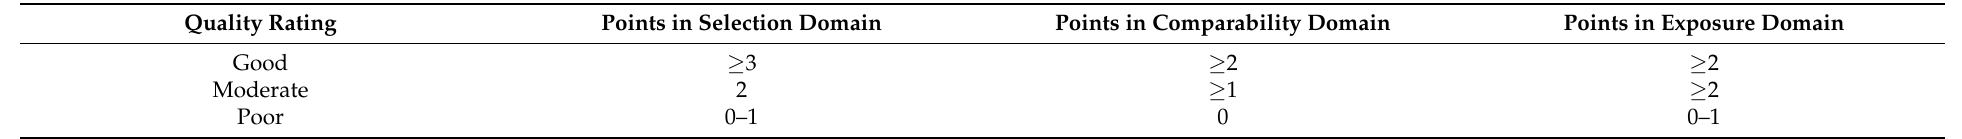
Table 4. Thresholds for Quality Assessment using the Newcastle-Ottawa Scale